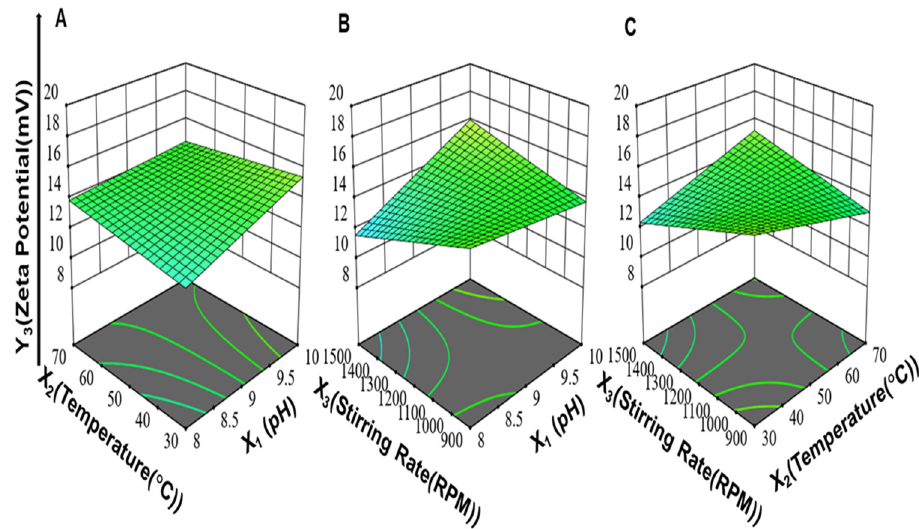
Figure 3. 3-D response surface plots for ( A ) the interaction between pH and reaction temperature (X 1 X 2 ), ( B ) the interaction between pH and stirring rate (X 1 X 3 ), and ( C ) the interaction between reaction temperature and stirring rate (X 2 X 3 ) on zeta potential of ZnO NPs while keeping the third variable at an average value between its high and low levels.